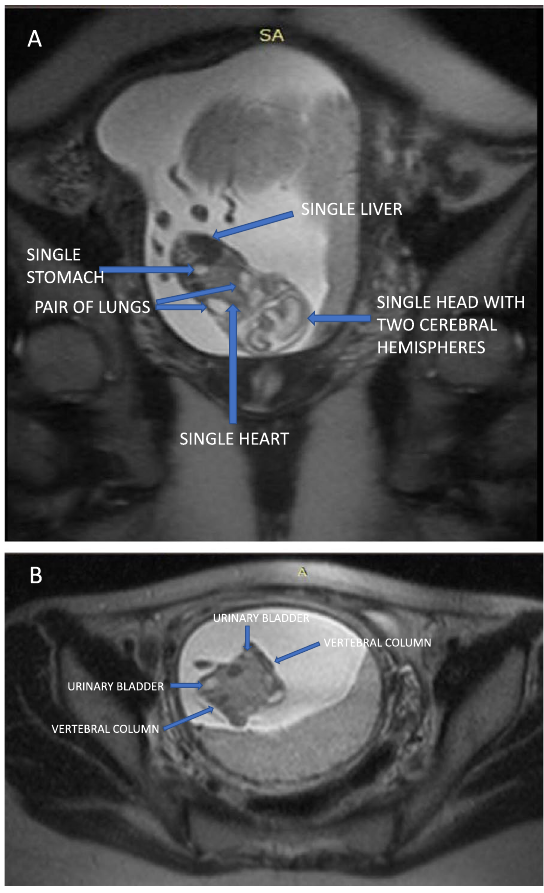
Fig. 2 A : Fetal MRI coronal T2WI confirmed findings of a single head with two optic globes, two cerebral hemispheres, two spinal canals seen to enter the base of skull, a single heart, a pair of lungs & shared liver(blue arrows) B : Fetus showed two urinary bladders and 2 pairs of upper and lower limbs.(blue arrows)